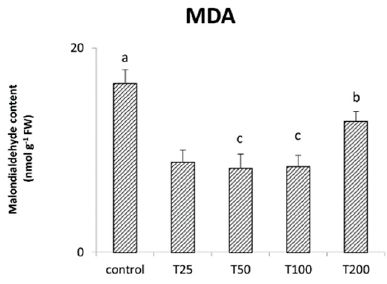
anthocyanin ( b ) recorded 14 days after the treatments with biogenic ZnO-NPs (T25, T50, T100 and T200) compared to the untreated control samples. Letters in the figure, when different, indicate statistically significant differences for p < 0.05 between